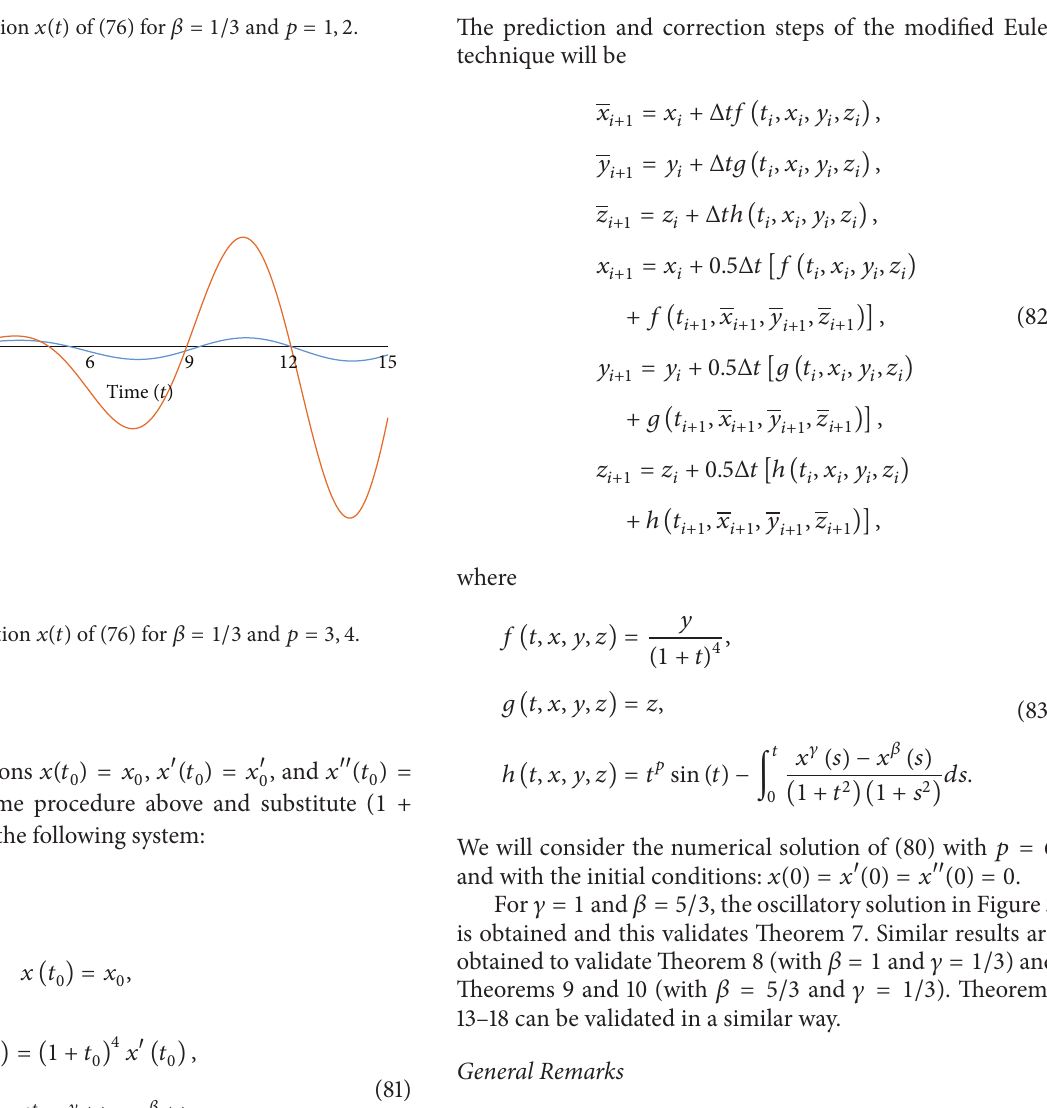
Figure 1: Solution 𝑥(𝑡) of (76) for 𝛽 = 1/3 and 𝑝 = 1, 2 .